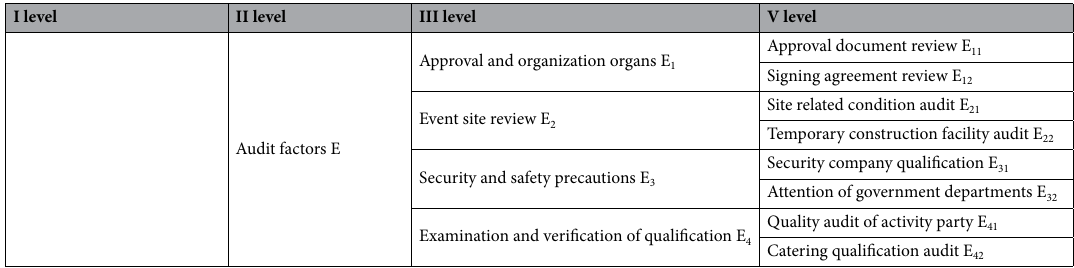
Table 1. Security risk assessment indicators system of important event.